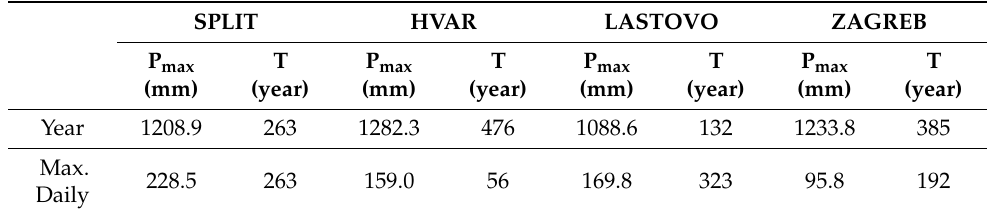
Table 4. Matrix of precipitations, P (mm), and their return periods, T (year), calculated for maximum annual and maximum annual daily precipitations measured at the four analysed stations in the 1948–2020 period, using GEV